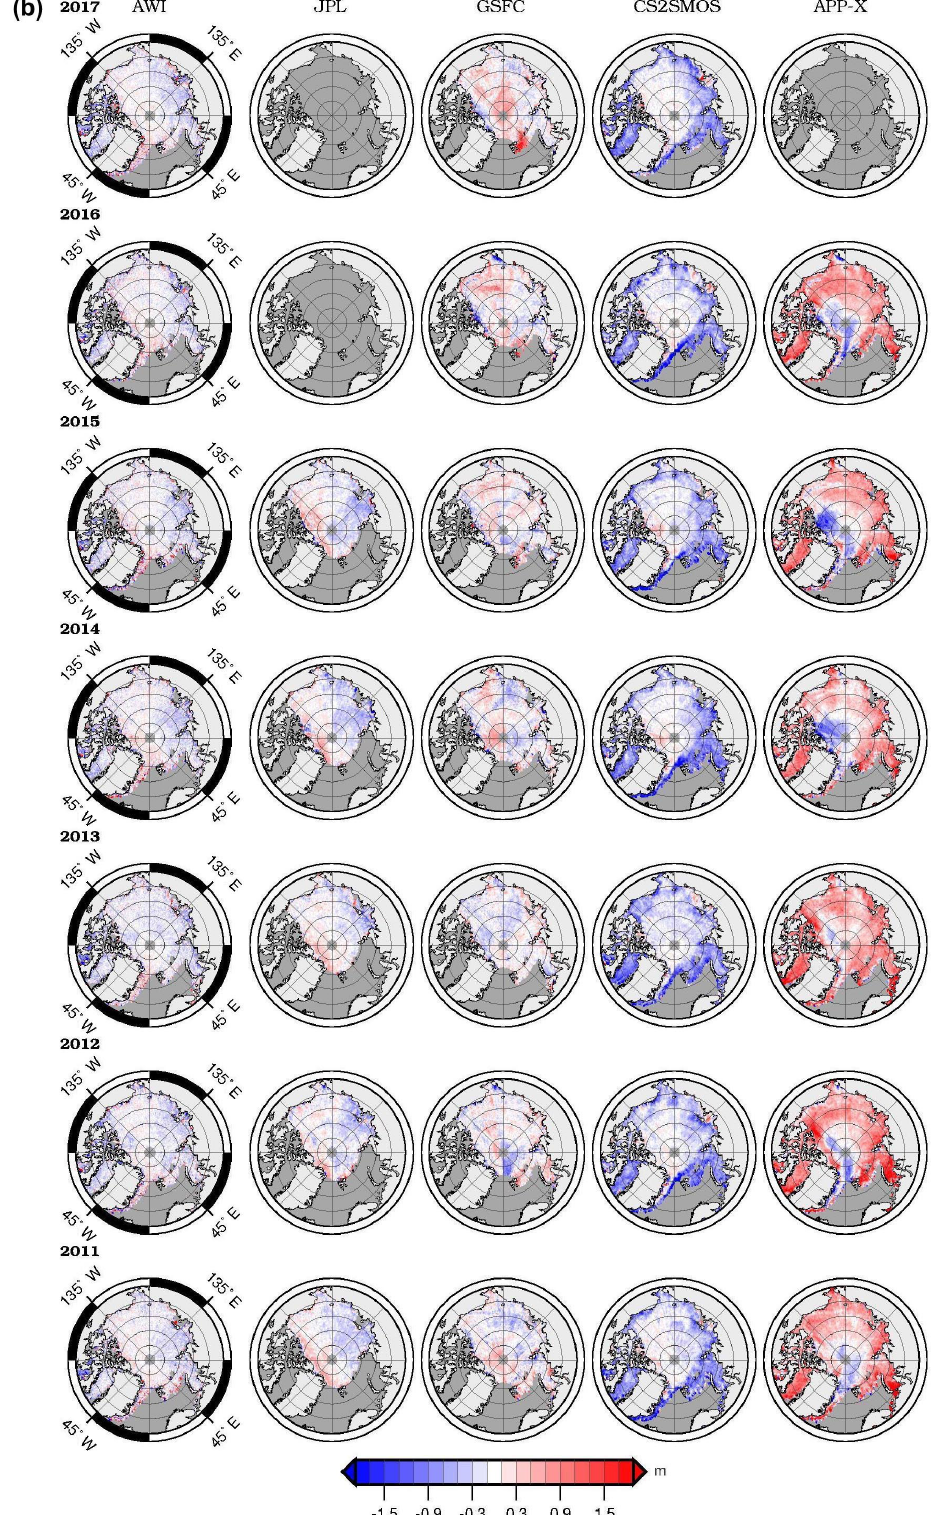
Figure 3. Maps of seasonally averaged sea ice thickness differences for the period 2011–2017, where the reference data set (CPOM) is subtracted from each data product, for (a) October–November and (b) March–April, for regions 1–14, where data are available. Red (blue) regions indicate areas where the seasonally averaged thickness is greater (less) than the reference data